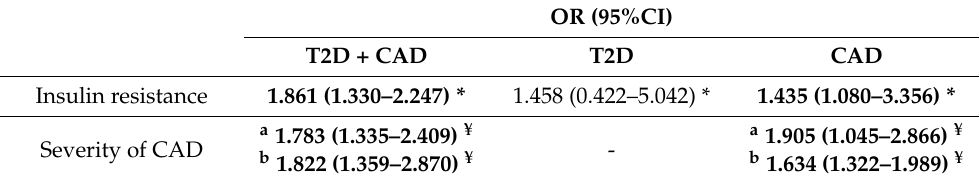
Table 4. Associations of rs17173608 with insulin resistance and severity of CAD.